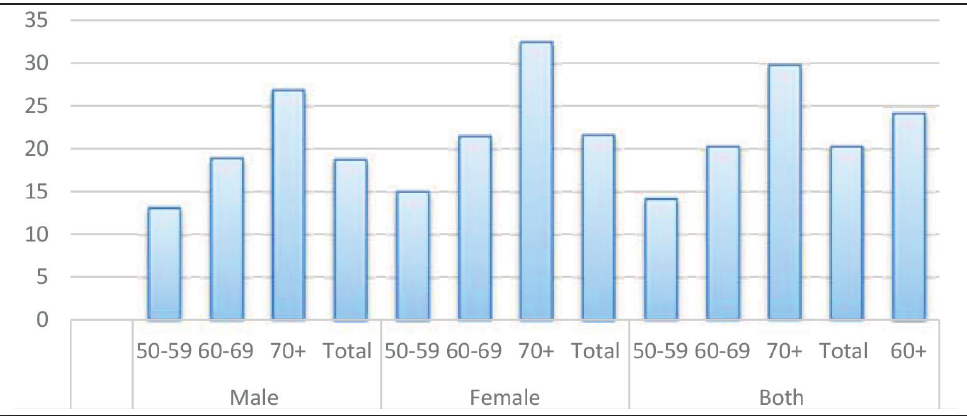
LASI, Longitudinal Ageing Survey of India; SRH, self-rated